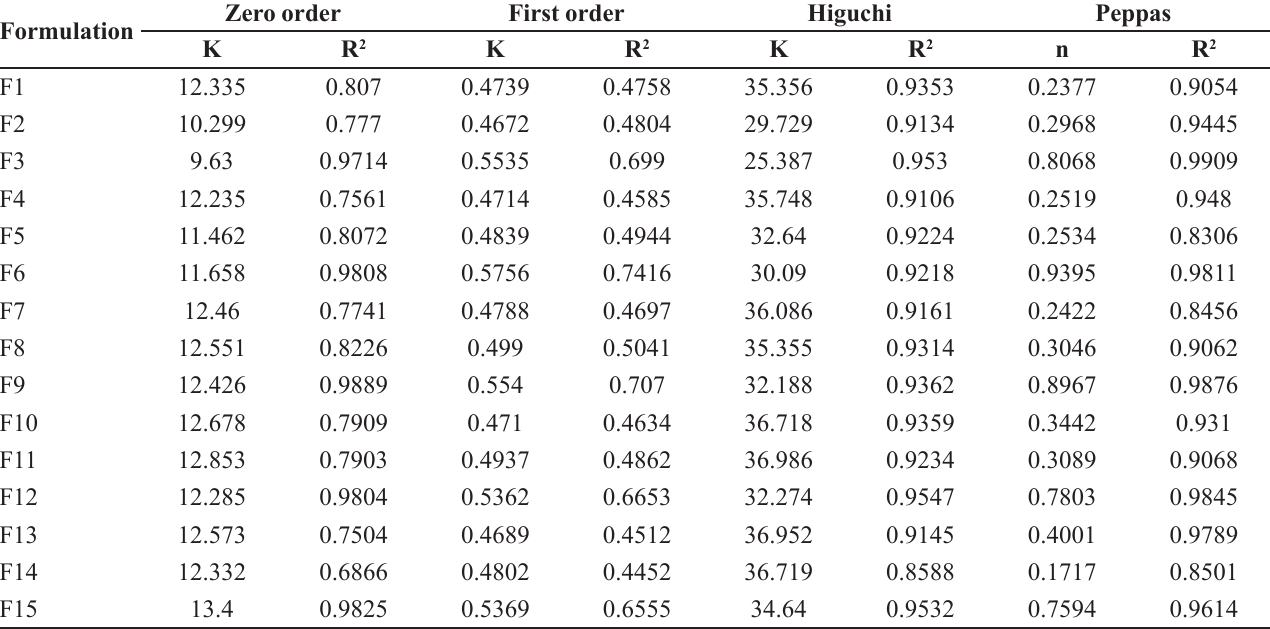
TABLE IV - Kinetic values obtained from different plots of theophylline microcapsule formulations